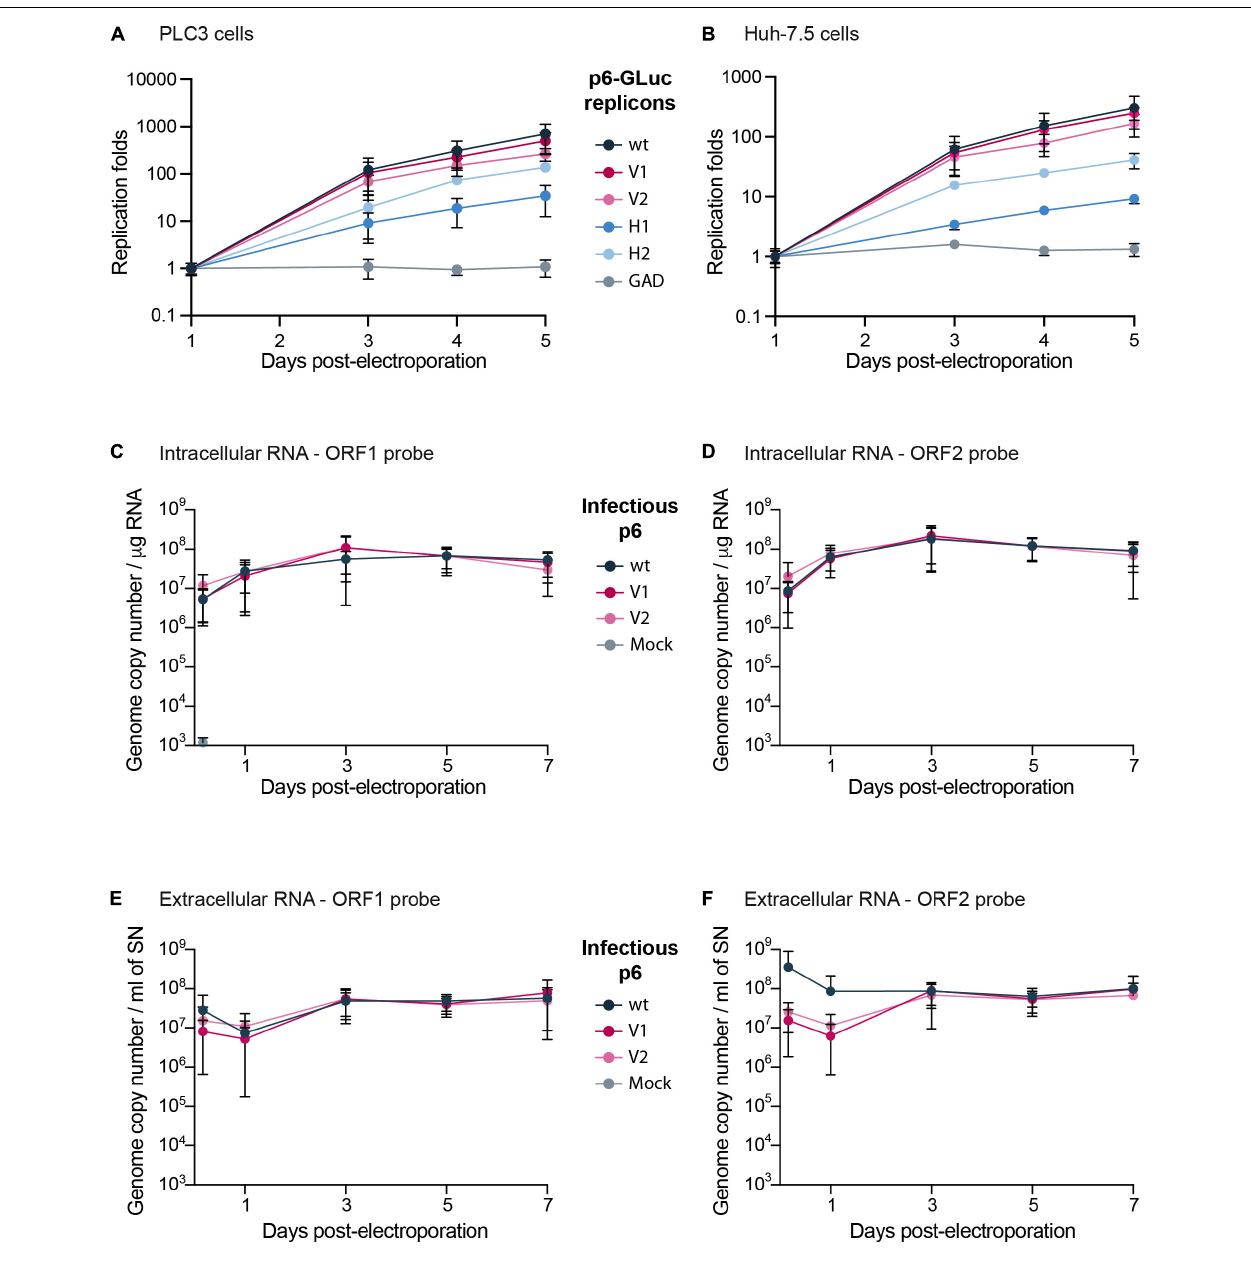
FIGURE 2 | Replication efficacies of HEV p6 replicons and infectious strain expressing epitope-tagged ORF1. (A,B) Replication efficacies of HEV replicons expressing tagged ORF1 in PLC3 (A) and Huh-7.5 cells (B) as measured by luciferase activity. The relative light units (RLU) were measured everyday for 5 days post-electroporation (dpe) by quantification of the Gaussia luciferase in the cell supernatants using a luminometer. Replication fold increases of the tagged p6-GLuc replicons (V1, V2, H1, H2) and non-tagged p6-GLuc replicons (wt, GAD) were normalized to 1 dpe. The p6-GAD-GLuc is a non-replicative construct that possesses a mutation from GDD to GAD which inactivates the ORF1 polymerase. Experiments were conducted three times with three technical replicates. (C–F) HEV RNA quantification in p6 electroporated-PLC3 cells expressing wild type or epitope-tagged ORF1. Intracellular (C,D) and extracellular (E,F) viral RNAs were quantified at 4 h post-electroporation (hpe), 1, 3, 5, and 7 dpe by RT-qPCR targeting either ORF1 (C,E) or ORF2 (D,F) . Mock-electroporated cells were used as negative controls and fluorescence signal was at or below the detection limit. Experiments were conducted three times with two technical replicates.